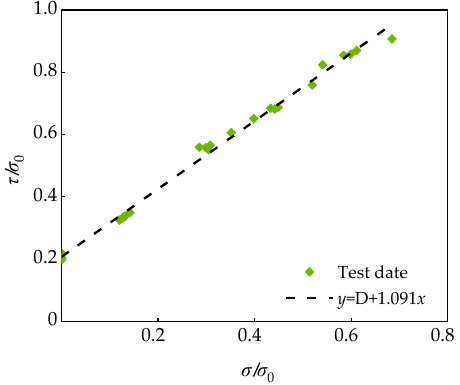
Figure 19. Relationship between τ / σ 0 and σ / σ 0 .